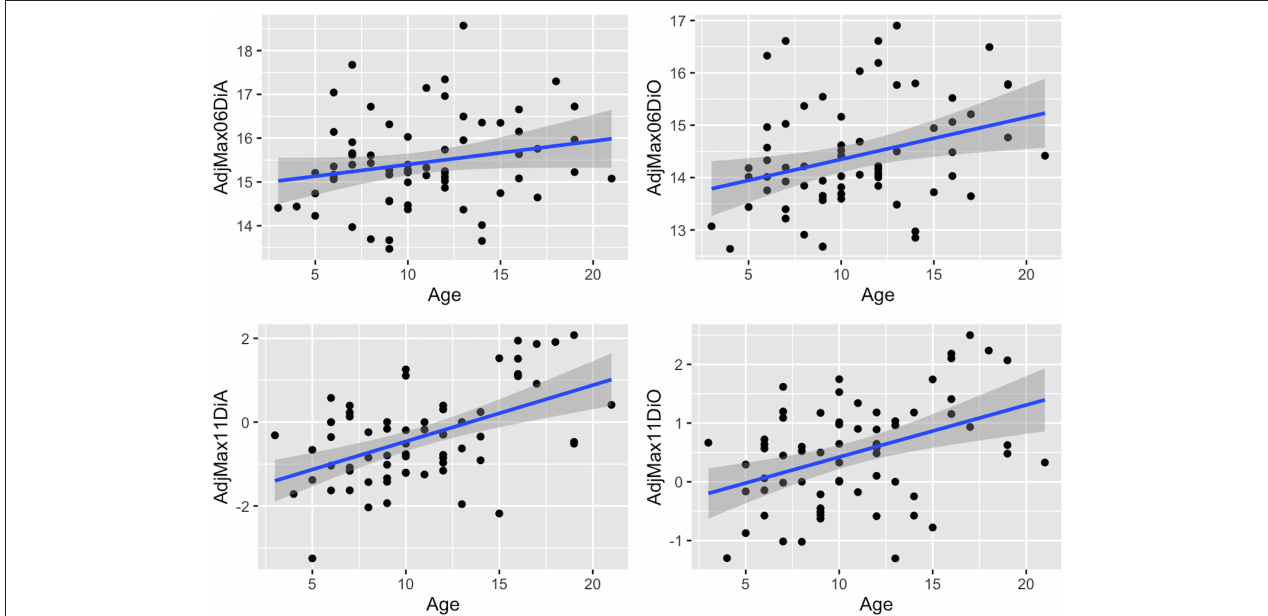
FIGURE 7 | Scatterplots with linear regression lines (blue) and confidence intervals (dark gray shading) plotted, showing associations between age (years) and adjusted rostro-caudal position measures (mean of left and right) for the mandibular teeth in 67 horses. AdjMand06DiO, adjusted mandibular 06 disto-occlusal measurement; AdjMand06DiA, adjusted mandibular 06 disto-apical measurement; AdjMand11DiO, adjusted mandibular 11 disto-occlusal measurement; AdjMand11DiA, adjusted mandibular 11 disto-apical